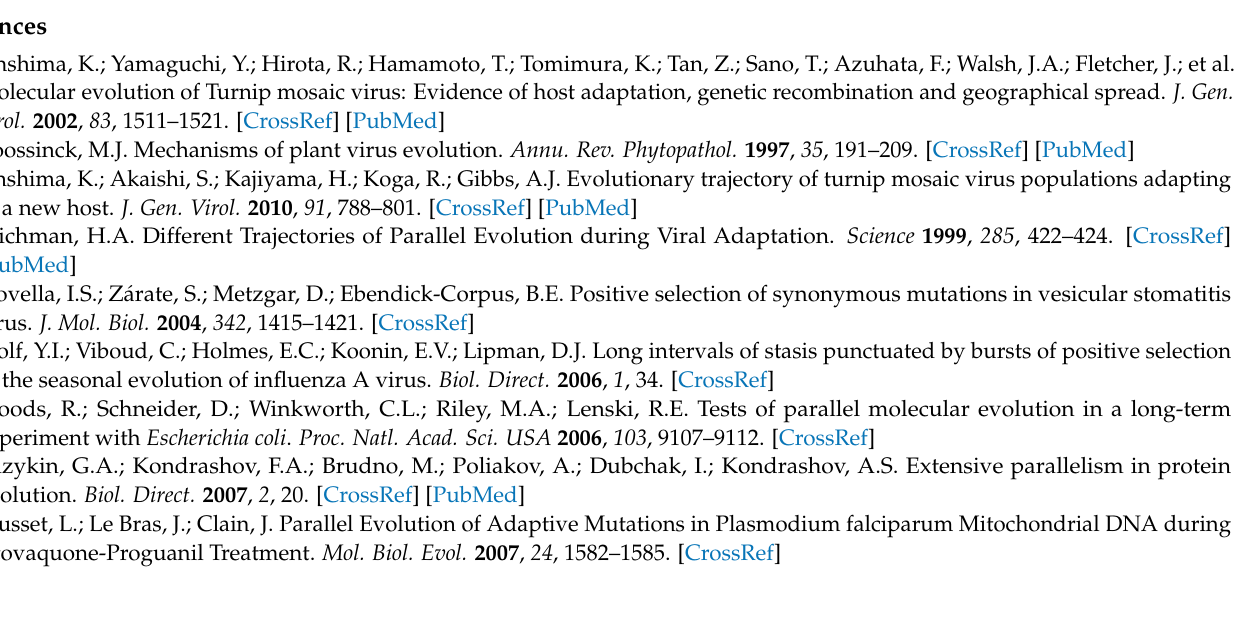
stem grooving virus (ASGV) coat protein gene using MUSCLE alignment implemented in SDTv1.2. Figure S2. Percentage amino acid identities of Korean apple stem grooving virus (ASGV) coat pro- tein gene using MUSCLE alignment implemented in SDTv1.2. Figure S3. Synonymous (dS) and Non-synonymous (dN) substitution of the apple stem grooving virus (ASGV) coat protein gene (a). Codon usage of ASGV from apple and pear reported sequences from China (b). Figure S4. Sec- ondary structure prediction of Korean apple stem grooving virus (ASGV) coat protein. Amino acid se-quences were rearranged corresponding to the phylogenetic analysis categorization of nucleotide sequences. Boxes rep-resent the significant differences between the two clades from the phylogenetic analysis. Predicted secondary structure results showed similar categorization of nucleotide phyloge- netic analysis. Secondary structures were predicted using the original Garnier Osguthorpe Robson algorithm (GOR I) provided by the EMBOSS suite embedded in Geneious Pro 8. Figure S5. Protein model prediction of selected Korean apple stem grooving virus (ASGV) coat protein sequences using i-TASSER. Phylogenetic relationship of the isolates is also shown. The accessions used for model prediction were under-lined. Table S1. List of coat protein gene sequences used in the nucleotide sequence